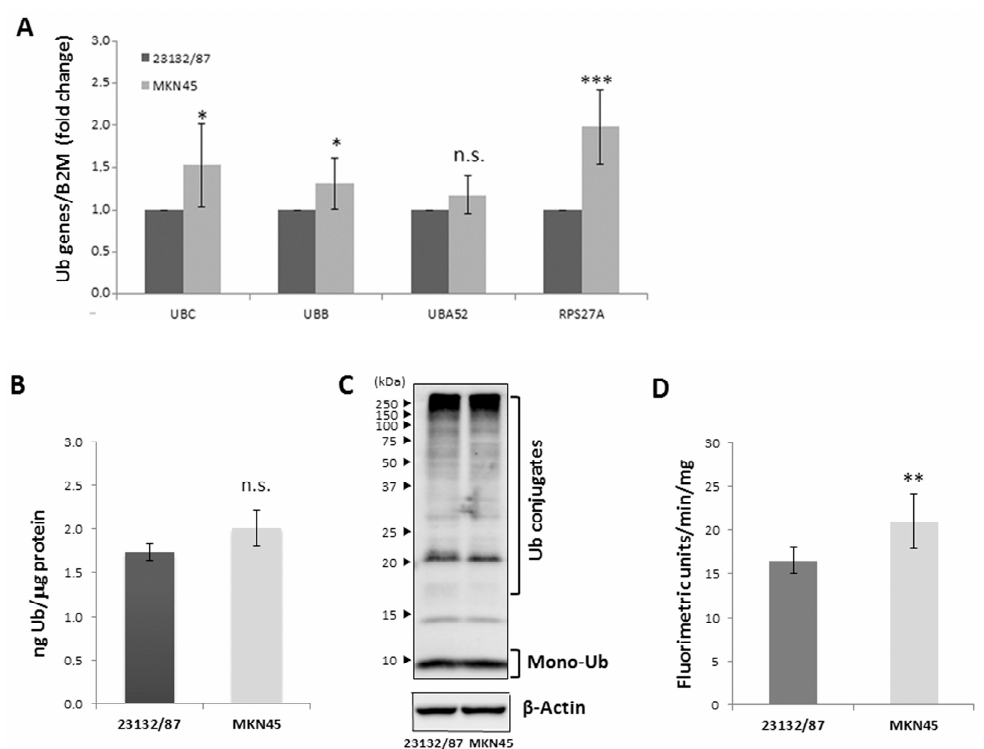
Figure 1. Evaluation of Ub gene expression, Ub protein levels and proteasome activity in 23132/87 and MKN45 cell lines. ( A ) The UBC , UBB , UBA52 and RPS27A mRNAs were measured by real-time quantitative PCR; the results were normalized to B2M mRNA and depicted as fold change compared with the values obtained in 23132/87 cells, set to 1. Data are means ± SD ( n = 6); * p < 0.05, *** p < 0.001; n.s. not significant. ( B ) Absolute quantification of total Ub ( n = 3) using different amounts of Usp2-treated protein extracts and a linear range of Ub standards run in parallel (see Figure S2). Results are given as ng Ub/µg protein; n.s. not significant ( p = 0.200). ( C ) Representative western immunoblots (n = 3) performed using total lysates (5 µg) of 23132/87 and MKN45 cells. The samples were loaded and probed with anti-Ub antibody to detect the poly-Ub and the mono-Ub pools; blots were reprobed with anti- β -Actin antibody, used as a loading control. Brackets indicate Ub conjugates and mono-Ub; arrowheads on the left indicate the molecular weight standards. ( D ) Proteasome activity was assayed in 23132/87 and MKN45 cell extracts using the fluorogenic peptide sLLVY-NH-Mec as a substrate ( n = 3); the obtained values were expressed as fluorimetric units*min − 1 *mg − 1 ; ** p < 0.01.